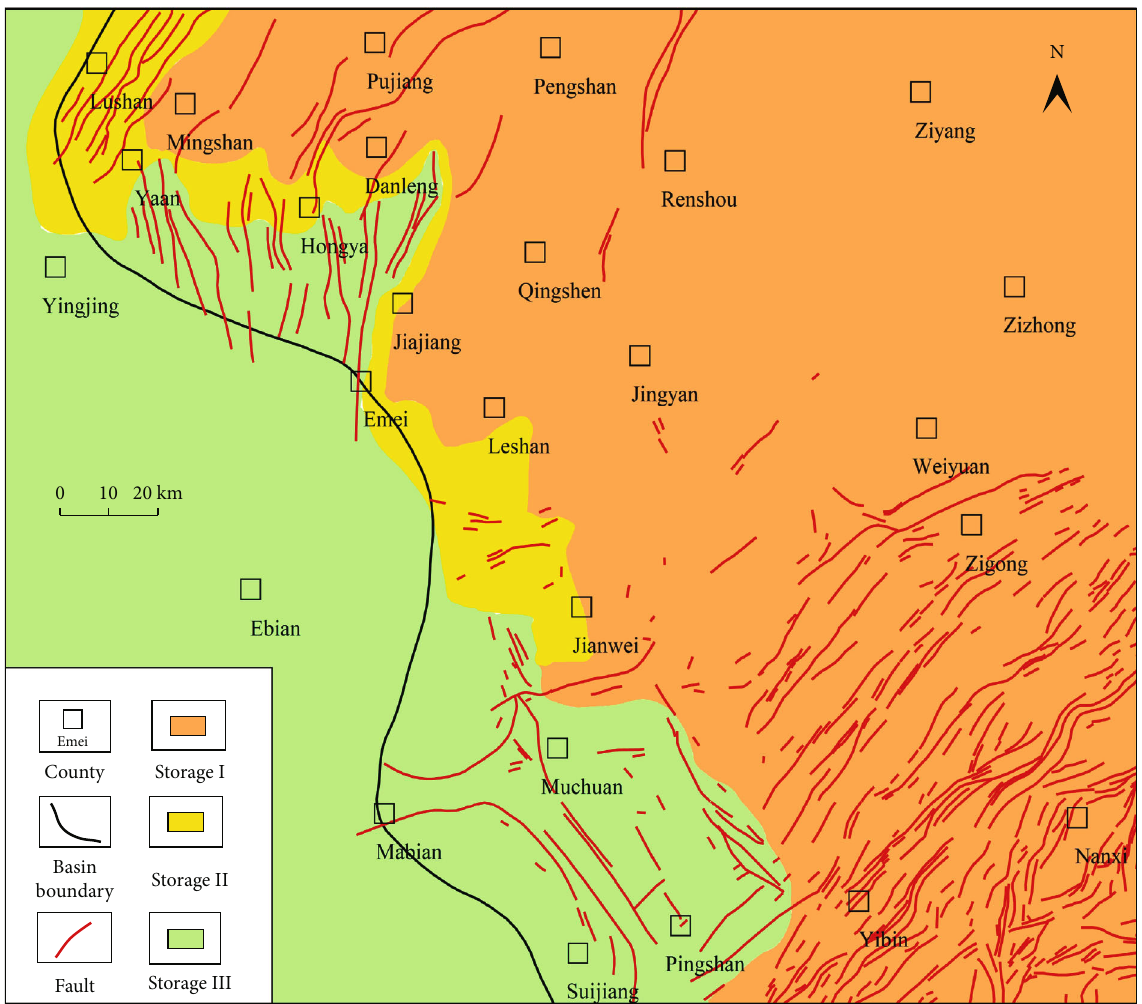
Figure 10: Planar distribution of the comprehensive evaluation of the Upper Permian hydrocarbon preservation in the southwestern part of the Sichuan